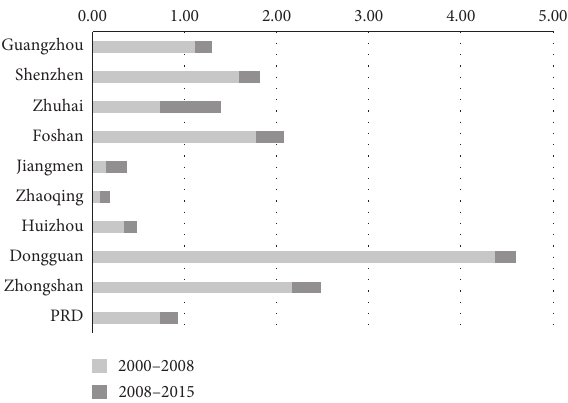
Figure 3: Urban expansion intensity of the Pearl River Delta urban agglomeration during 2000–2008 and